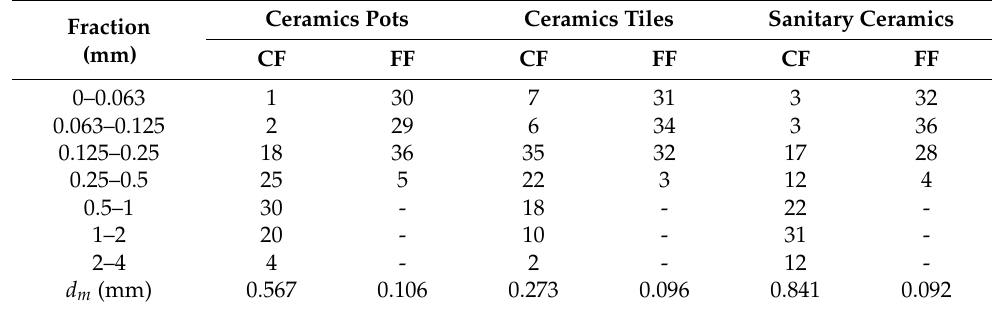
Table 2. The granular composition of the used ceramic fillers. Coarse fillers (CF) and fine fillers (FF).